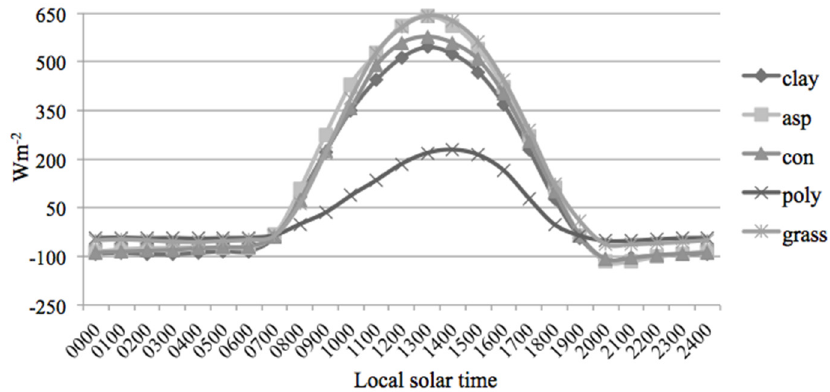
Figure 3. Net radiation flux resulting from each material (Q N